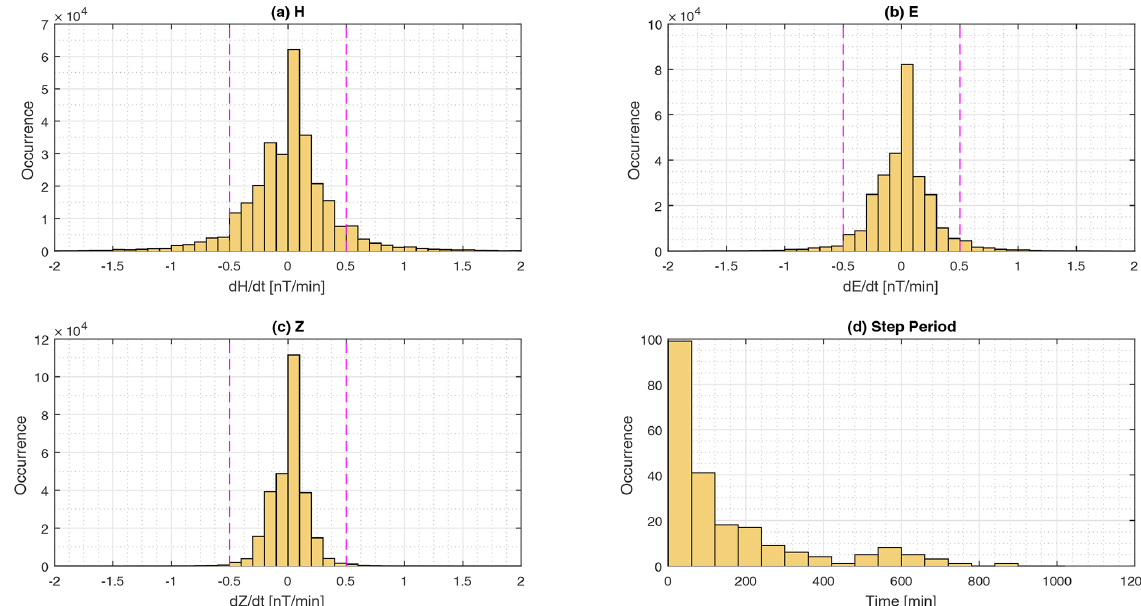
Figure 6. Histogram of rate of change and step periods at KPG observatory. Panels (a) , (b) , and (c) are histograms of the rate of change in the H , E , and Z components, respectively, and (d) is the step period. Magenta lines in the histograms of the rate of change are the assumed step